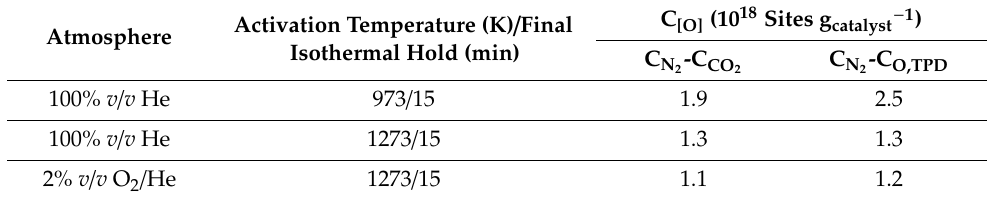
Table 3. Activation conditions and concentration of non-active oxygen (C [O] ) after N 2 O decomposition (at 523 K) over FeZSM-5 2300Fe .